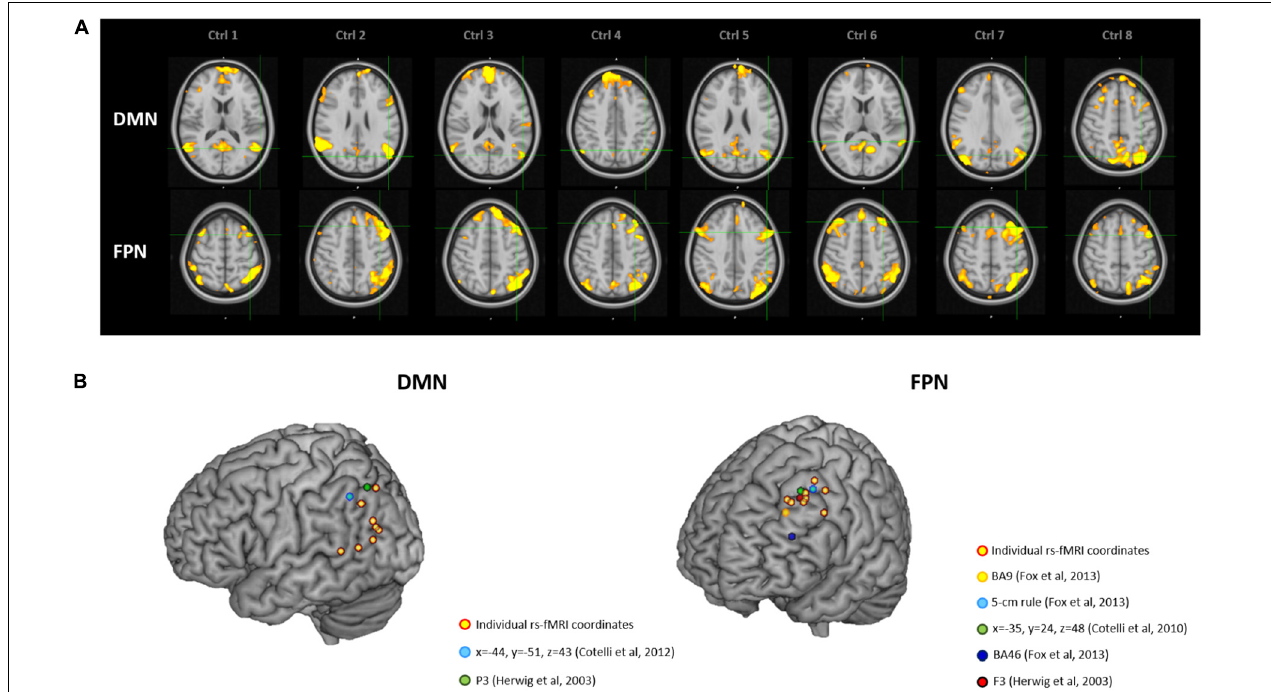
FIGURE 3 | (A) Location of the individual targets (overlaid onto the standard MNI template) for default mode network (DMN) stimulation (top panel) and frontoparietal network (FPN) stimulation (bottom panel) in eight healthy elderly controls. Images are shown in radiological convention (left denotes right). (B) 3D render showing the individual targets (red-yellow) overlaid onto the standard MNI template. For the DMN, green target corresponds to P3 (Herwig et al., 2003), and light-blue to IPL (Cotelli et al., 2012). For the FPN, yellow target corresponds to DLPFC BA9 (Fox et al., 2013), light-blue to DLPFC-5 cm rule (Fox et al., 2013), blue to DLPFC BA46 (Fox et al., 2013), red to F3 (Herwig et al., 2003), green to DLPFC BA8/9 (Cotelli et al., 2010). DMN, default mode network; FPN, fronto-parietal network; BA8/9, Broadmann areas 8 and 9; BA9, Broadmann area 9; BA46, Broadmann area 46; IPL, inferior parietal lobule; DLPFC, dorsolateral prefrontal